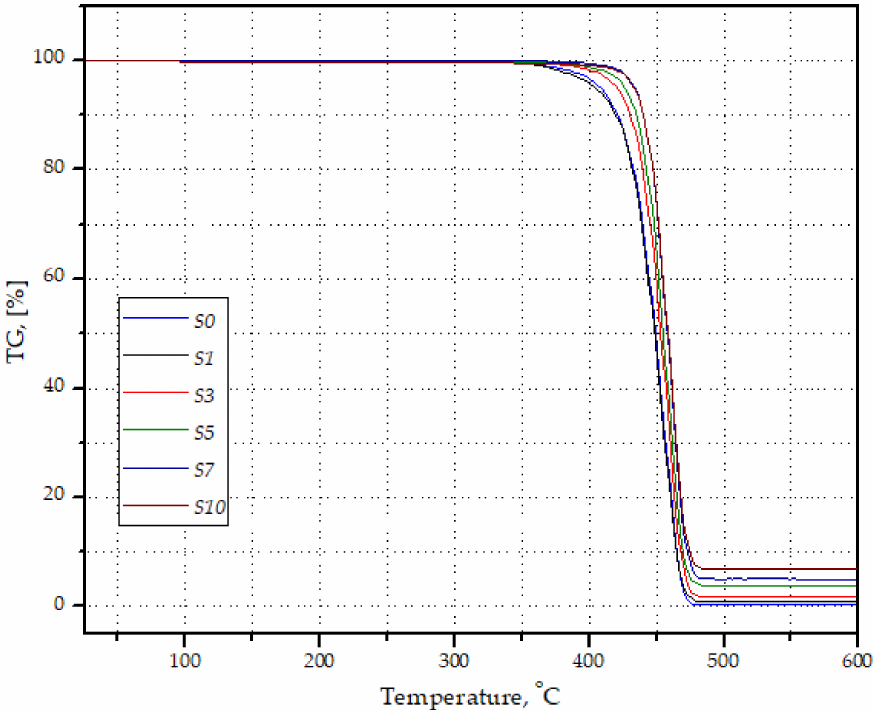
Figure 6. Selected curves of weight loss of PP/silica samples as a function of temperature, recorded during TG